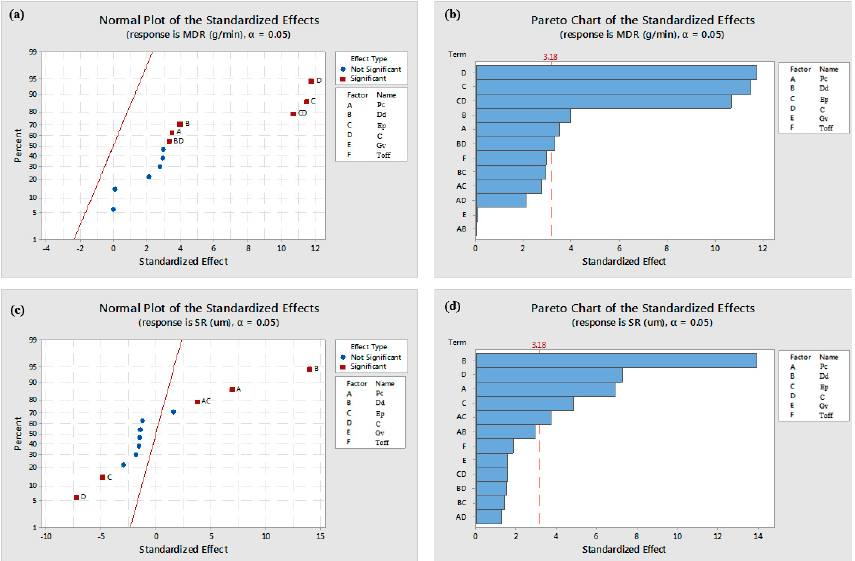
Figure 8. Screening experimental results showing the most significant parameters and insignificant parameters in the normal plot and Pareto chart of Hydroxyapatite Deposition Rate (HDR) and Surface Roughness (SR). All the factors extended beyond the red line in the Pareto chart are significant while those below the line are considered insignificant.